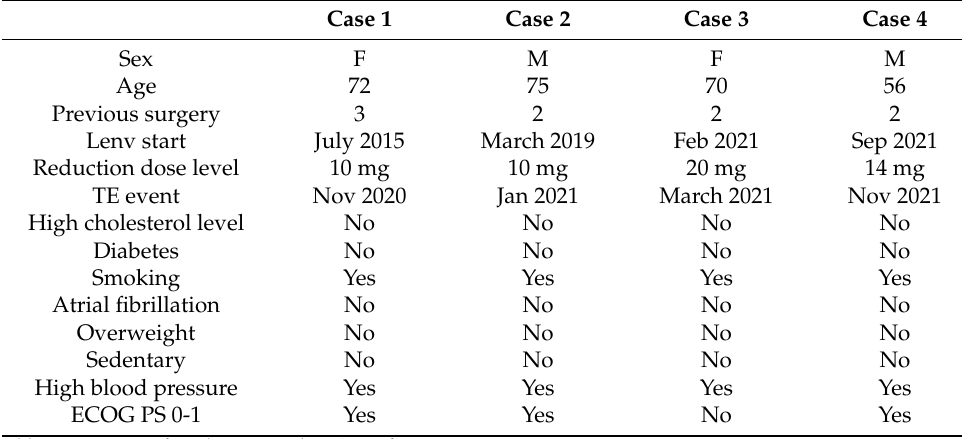
High cholesterol level